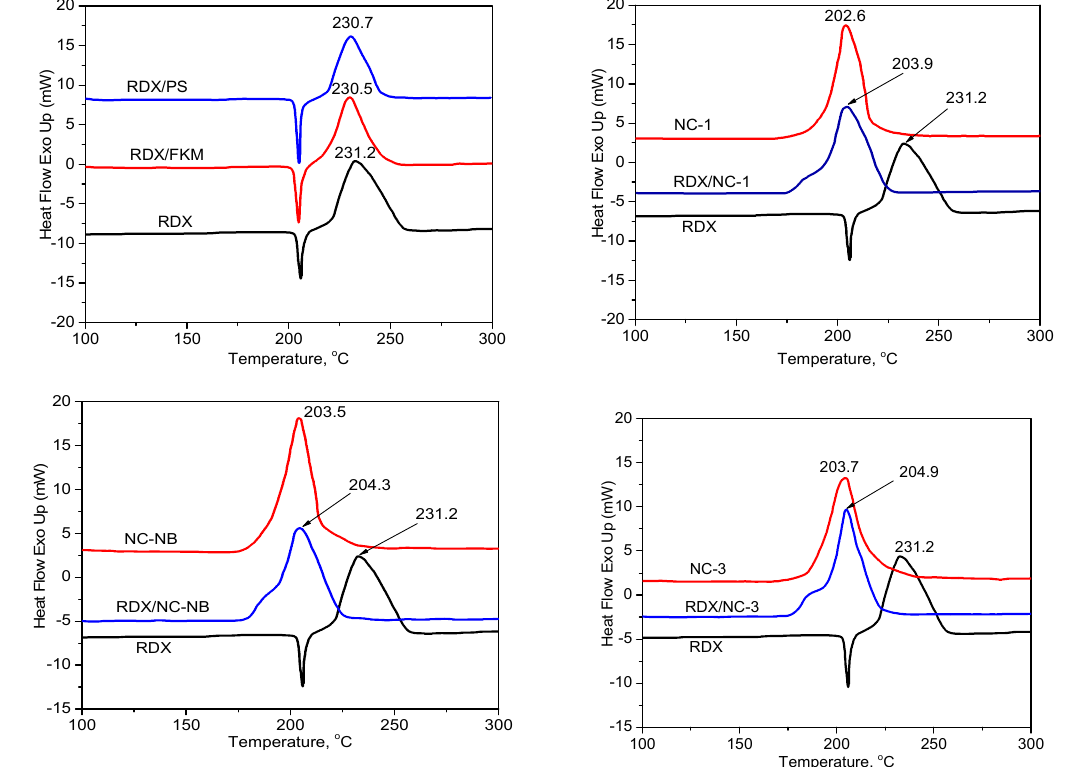
Figure 1. DSC curves of RDX and mixtures based on RDX.